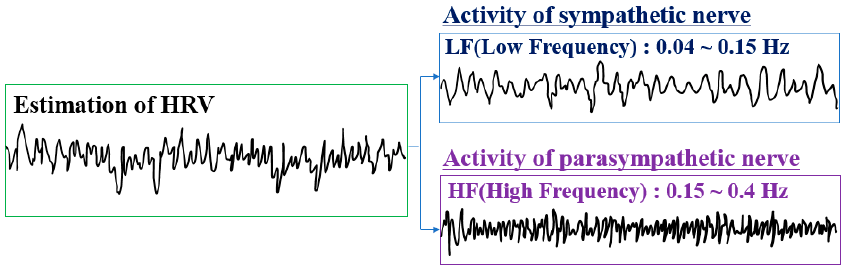
Figure 3. Determination of autonomic nervous system activation by power spectrum analysis of HRV.